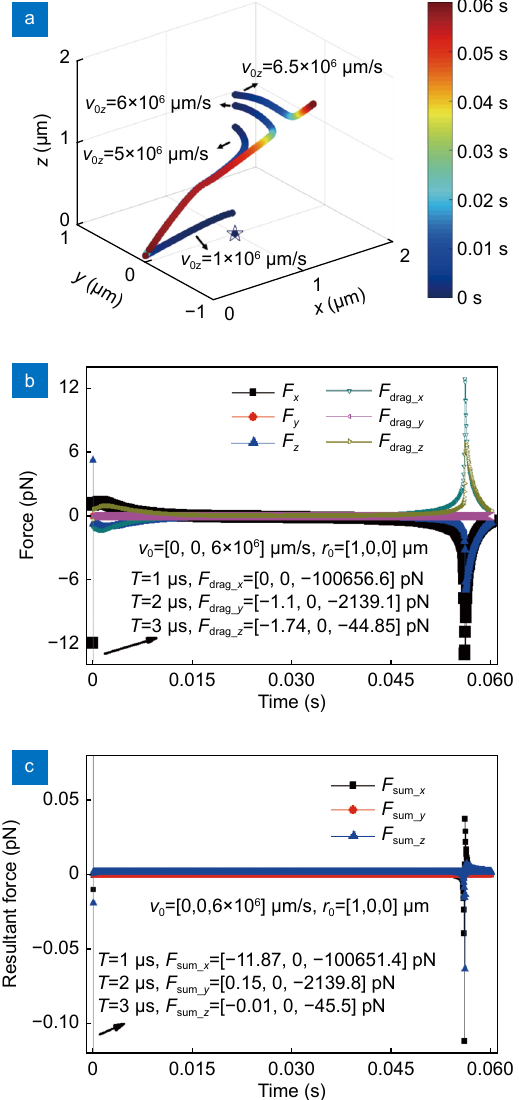
Fig. 7 | ( a ) The 3D trajectories of a micro-sphere at different initial velocities in the z -axis with v 0 x =1×10 6 , 5×10 6 , 6×10 6 , and 6.5×10 6 μm/s, when the initial position is r 0 x =[1,0,0] μm. The plots of ( b ) the optical force and drag force, and ( c ) the resultant force over time of the micro-sphere when v 0 =[6.5 × 10 6 ,0,0] μm/s, and r 0 x =[1,0,0]